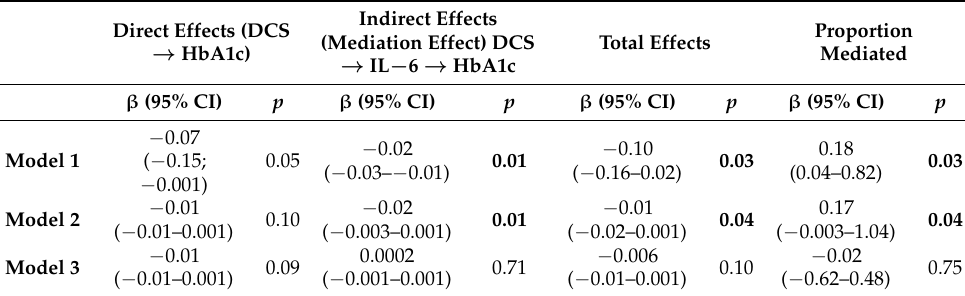
Table 3. Standardized effects ( β estimate, 95% CI) and p -values of diurnal cortisol slope (DCS) on HbA1c via IL-6 as a mediator, and the proportion of association between cortisol and HbA1c mediated by IL-6 ( n =